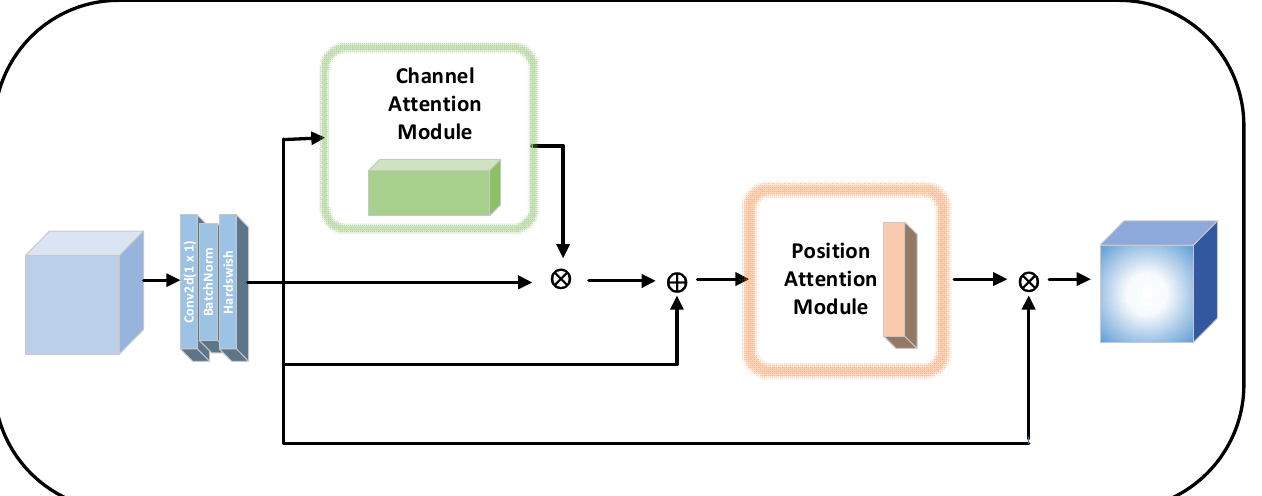
Figure 4. Structure of OCAM attention module.